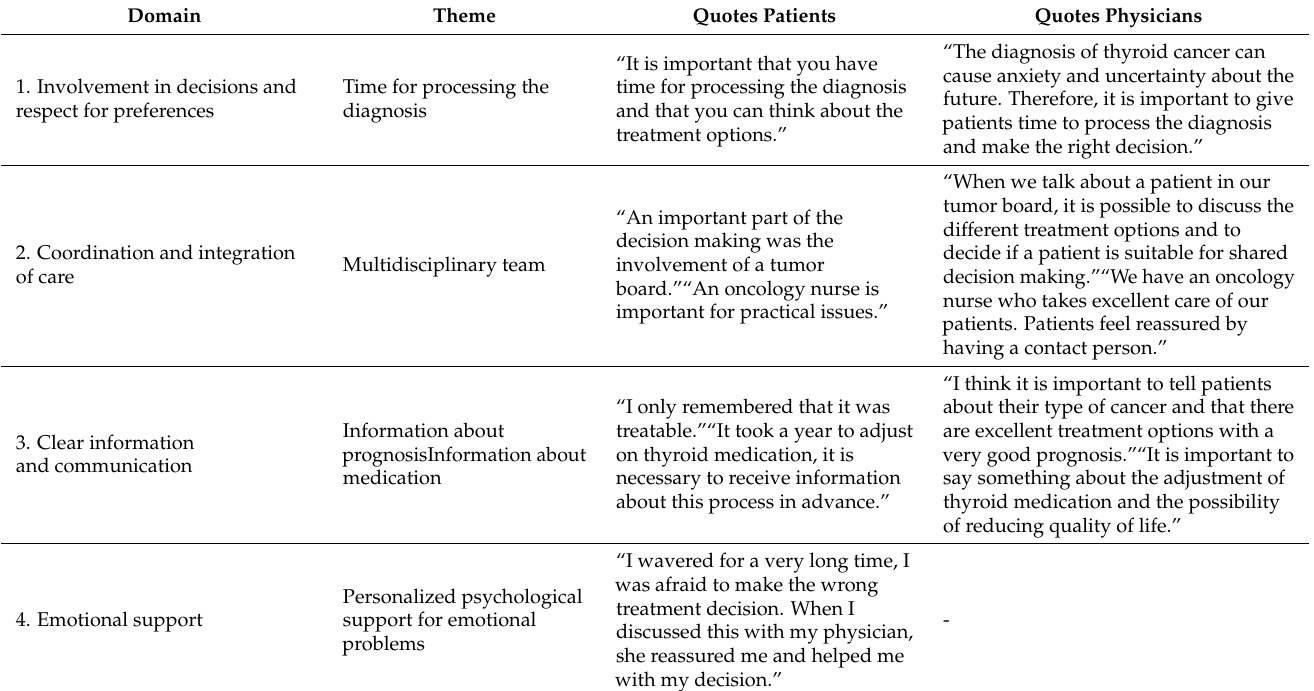
Table 3. Quotes of patients and physicians corresponding to some of the themes for the surgery decision regarding “thyroid lobectomy or total